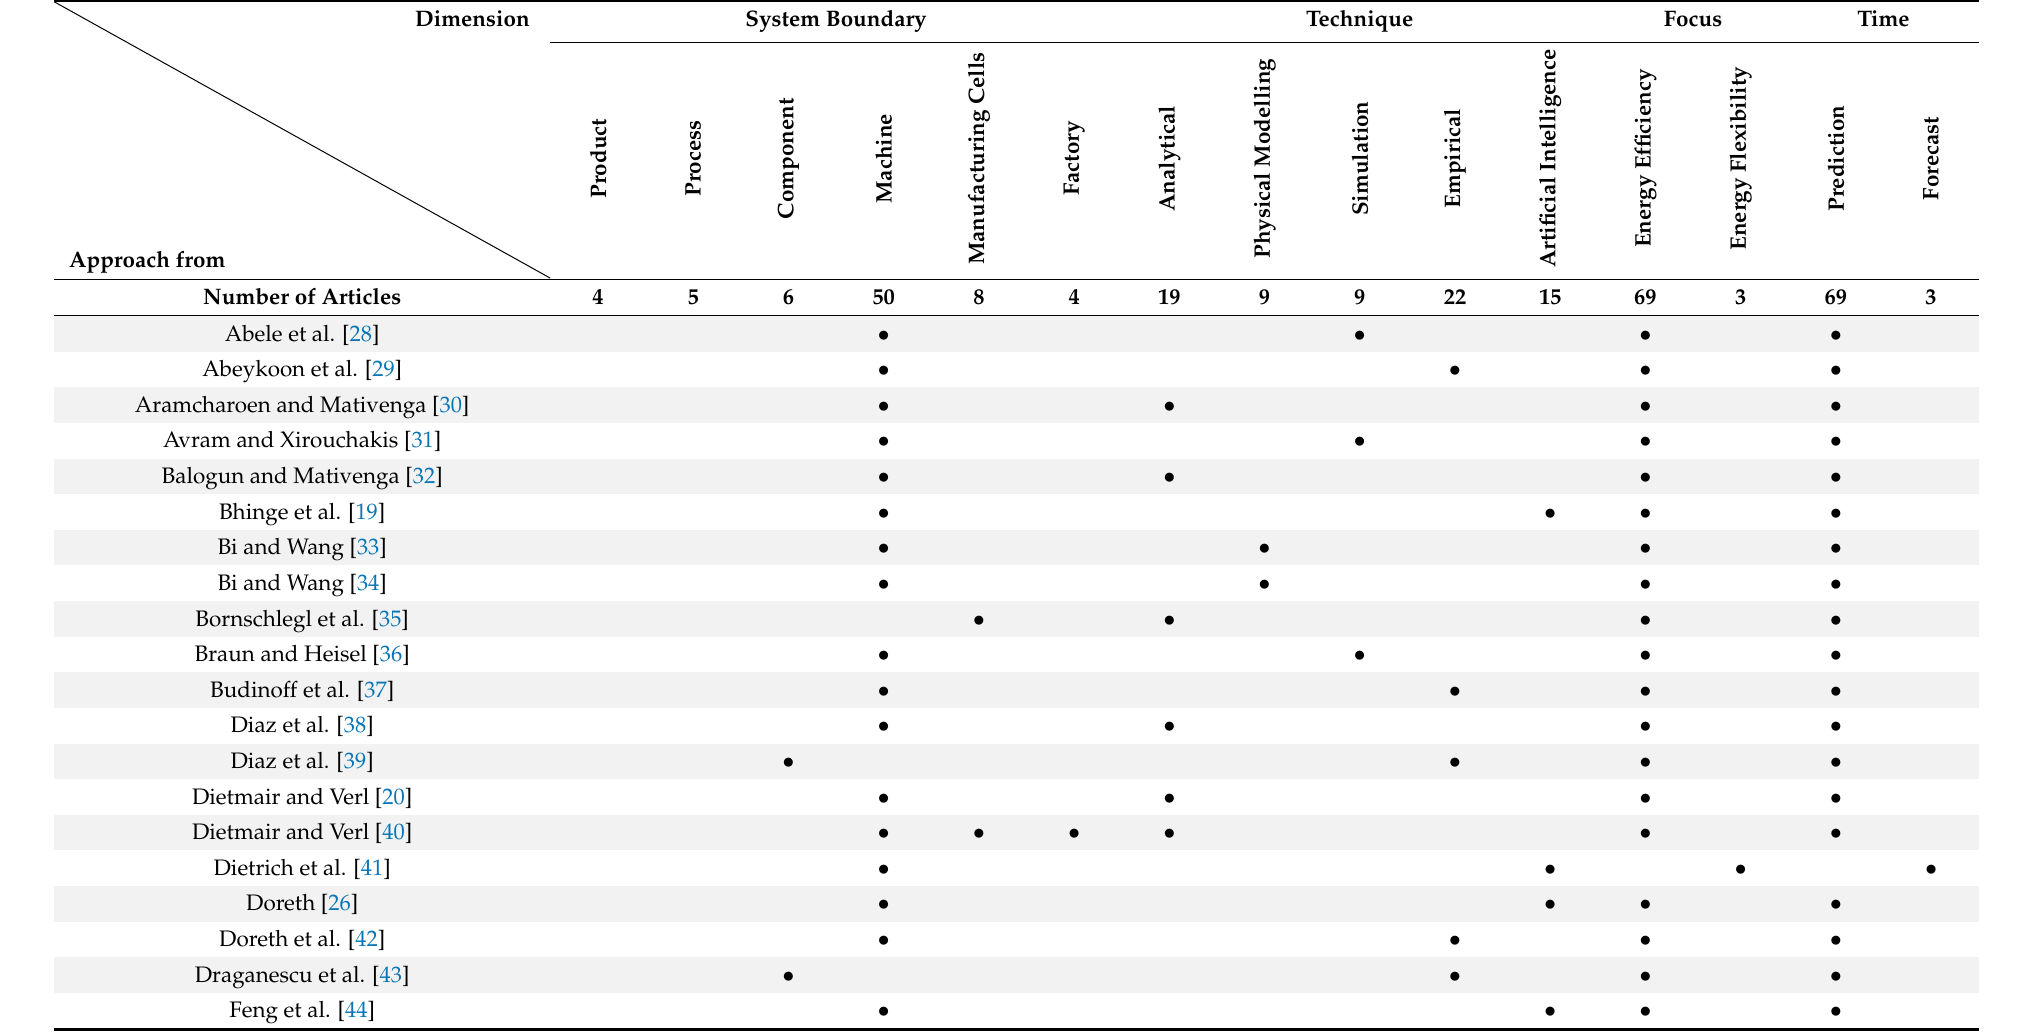
Table 2. Classification for Dimensions Modelling Technique, System Boundary, Focus, and Horizon (Time).